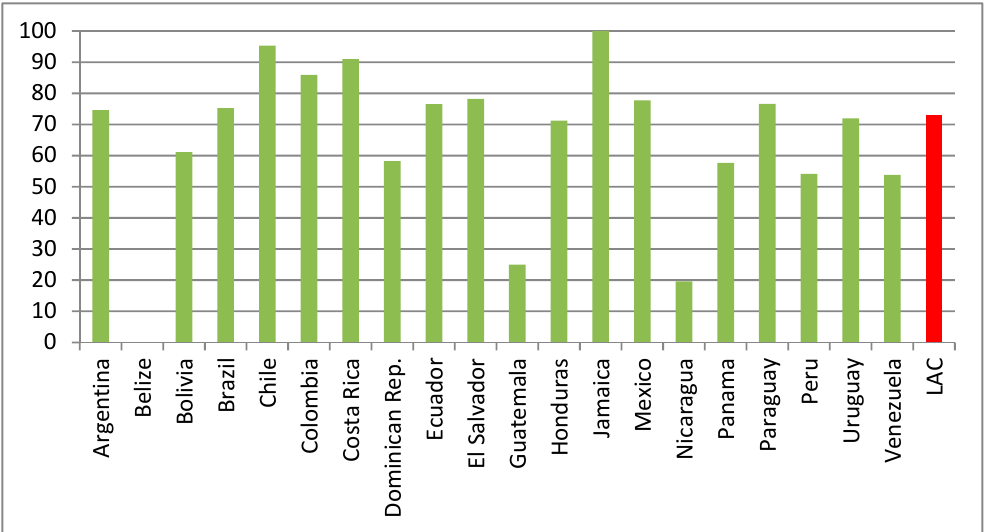
Figure 2. Controlled MSW disposal methods (landfills and controlled dumps) in LAC as a percentage of population covered [19].